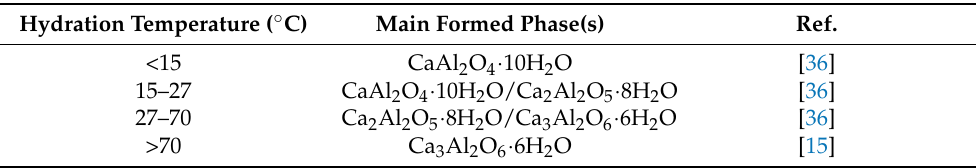
Table 2. Most-formed calcium aluminates in dependence on the hydration temperature. Hydration Temperature ( ◦ C)